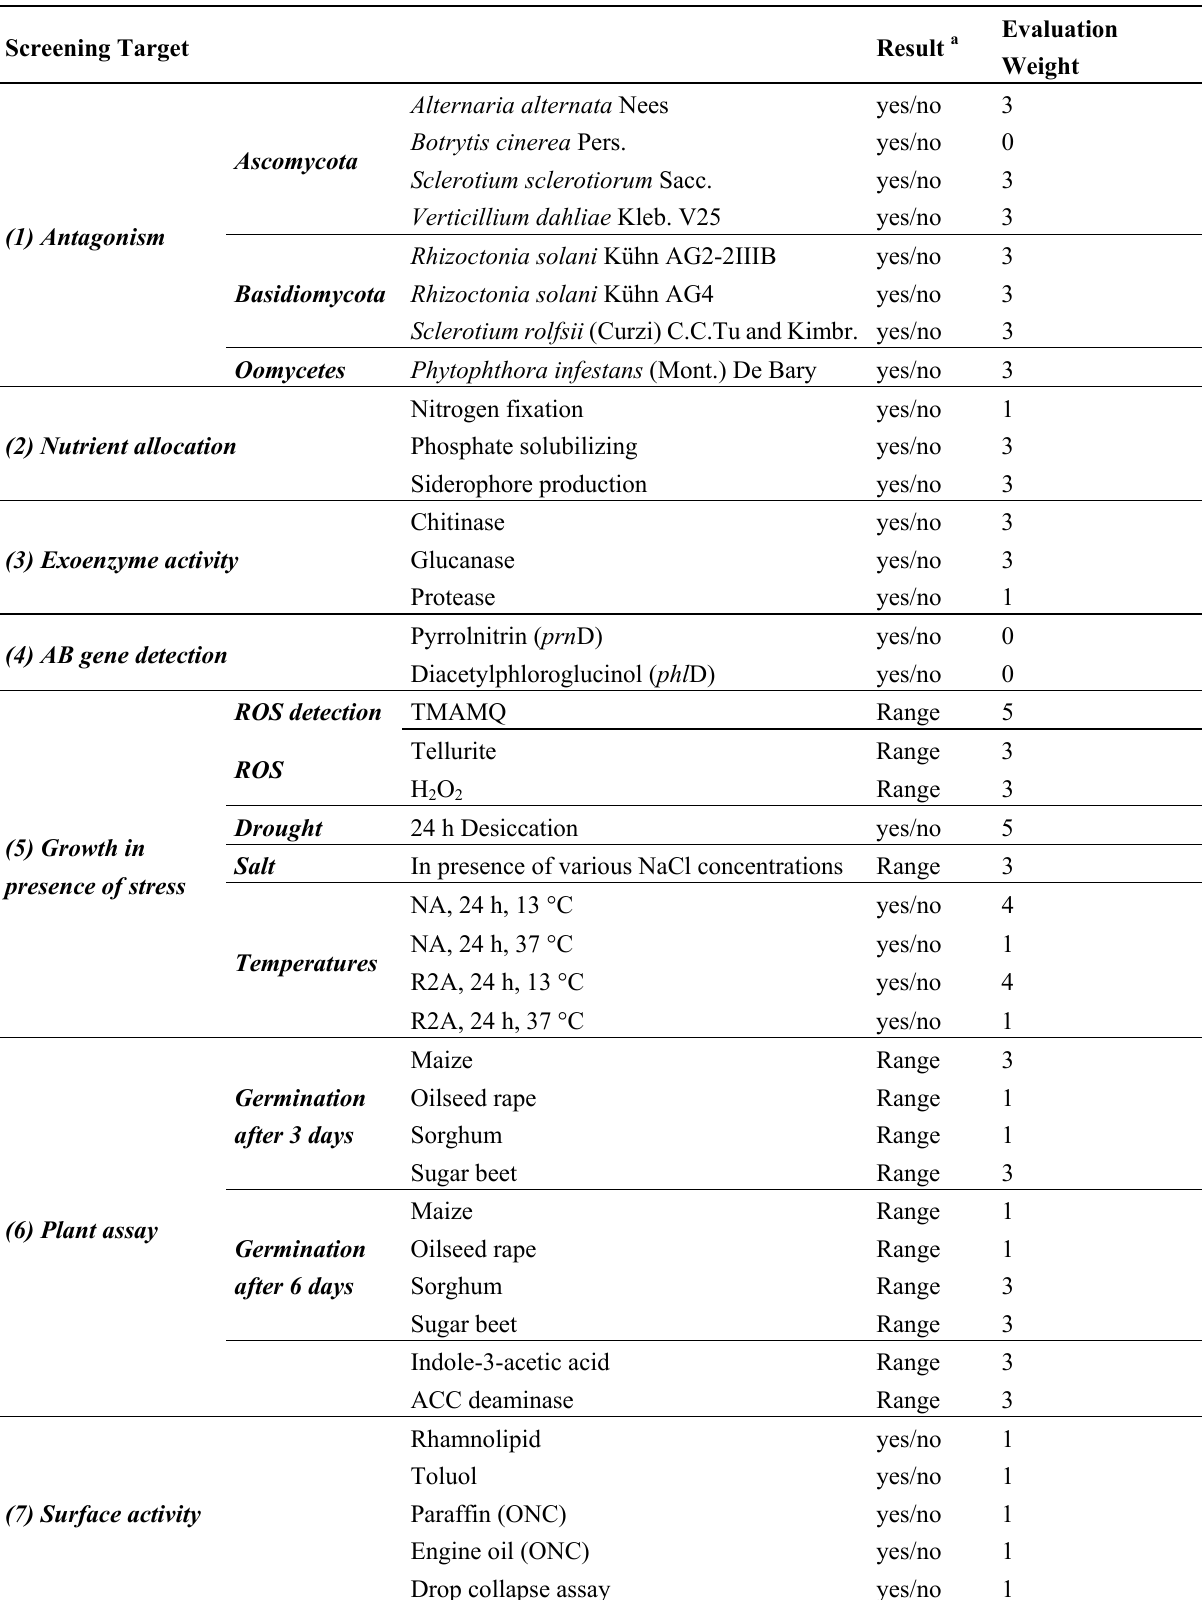
Table 1. Scoring scheme. a yes/no: positive (1) or negative (0) result. Range: high, 1; low, 0. Abbreviations: AB, antibiotic; TMAMQ, tetramethoxy azobismethylene quinone; ROS, reactive oxygen species; ONC, overnight